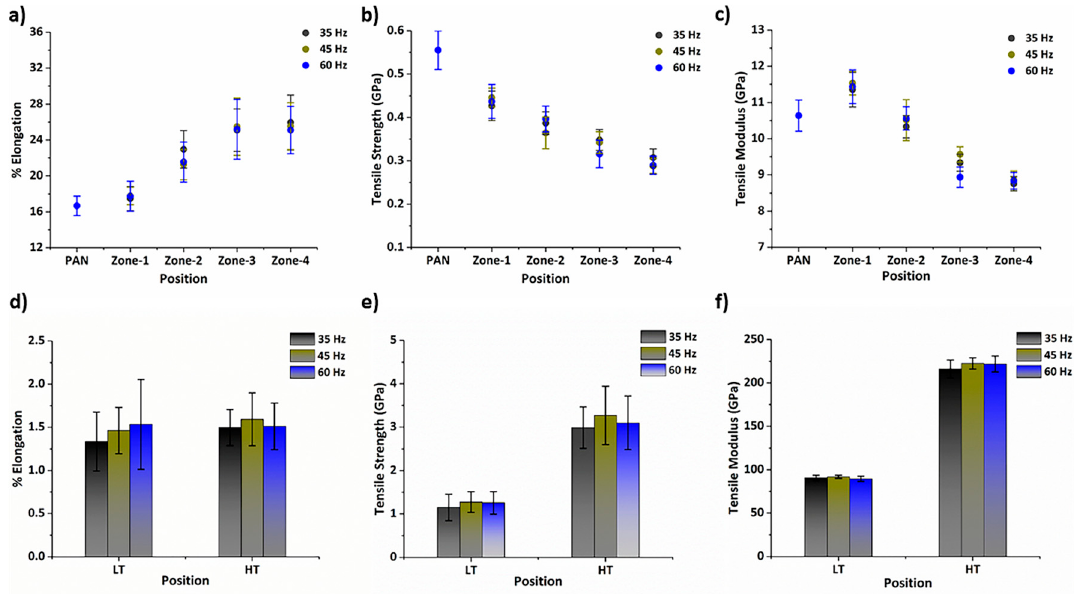
Figure 6. Tensile properties of stabilized and carbon fibers (LT and HT) with respect to recirculation fan frequencies with the ( a ) % elongation at break, ( b ) tensile strength, ( c ) tensile modulus of stabilized fibers, and the ( d ) % elongation at break, ( e ) tensile strength, and ( f ) tensile modulus of carbon fibers extracted from LT and HT furnaces.